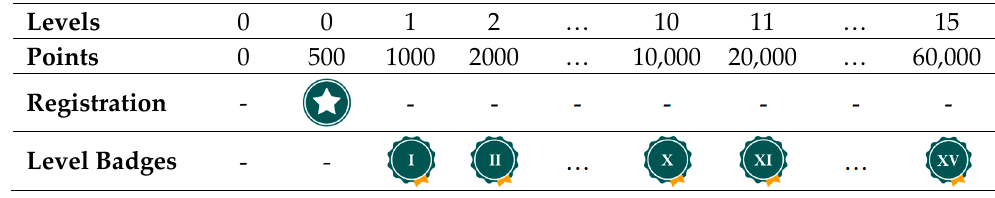
Table A3. Gamification–Points tally (and level badges).